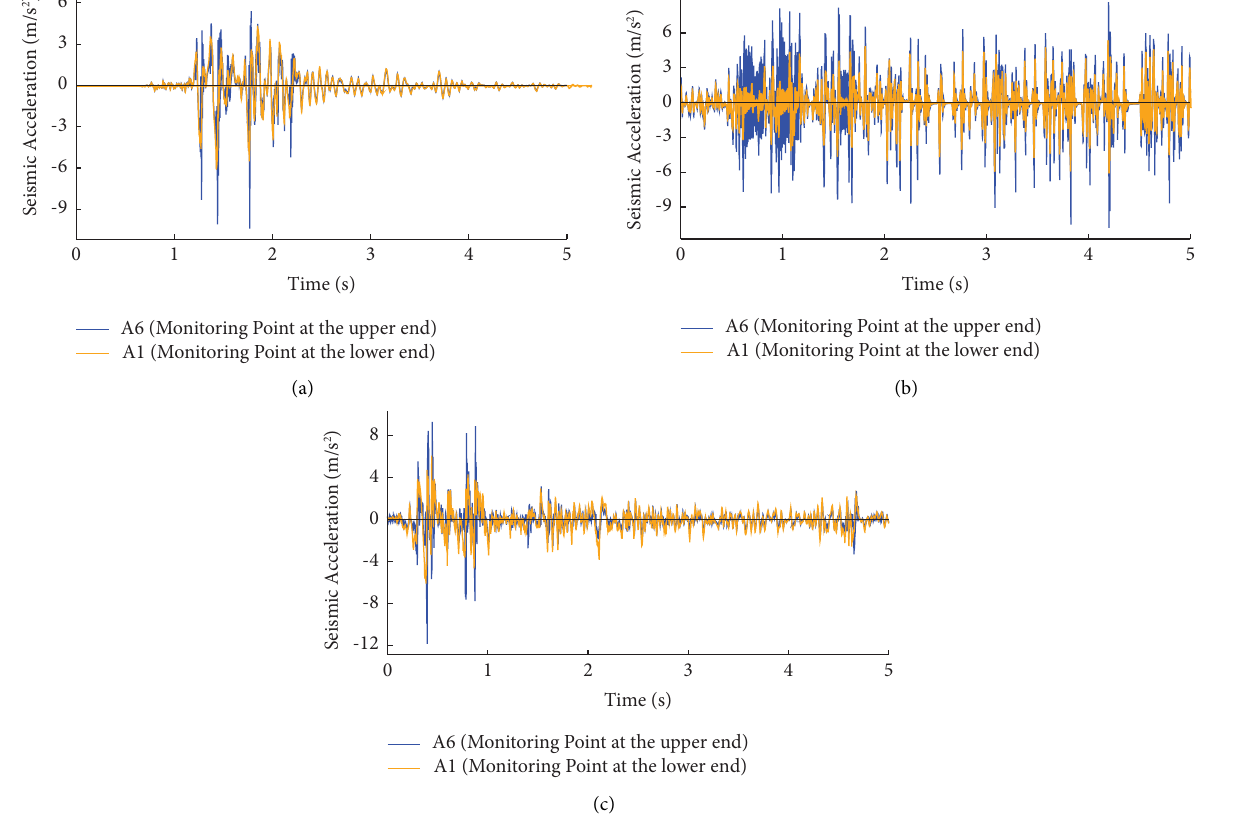
Figure 5: A1 and A6 acceleration history curves of reclining walls ( ε � − 20 ° , 0.6 g). (a) Kobe wave. (b) Wenchuan wave. (c) EL Centro